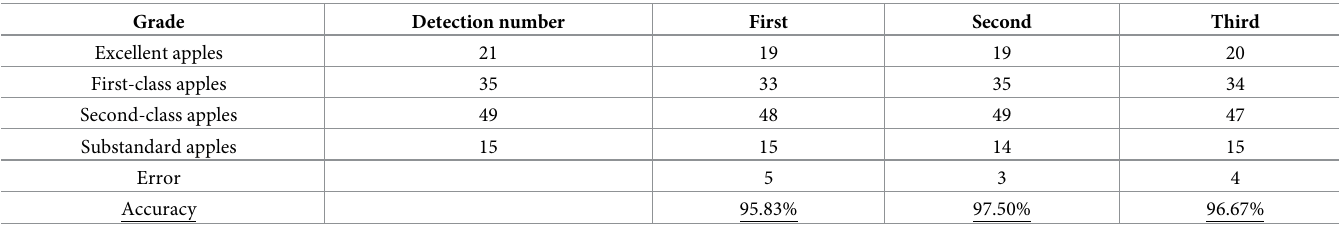
Table 6. The results of apple quality grading according to the national standard.